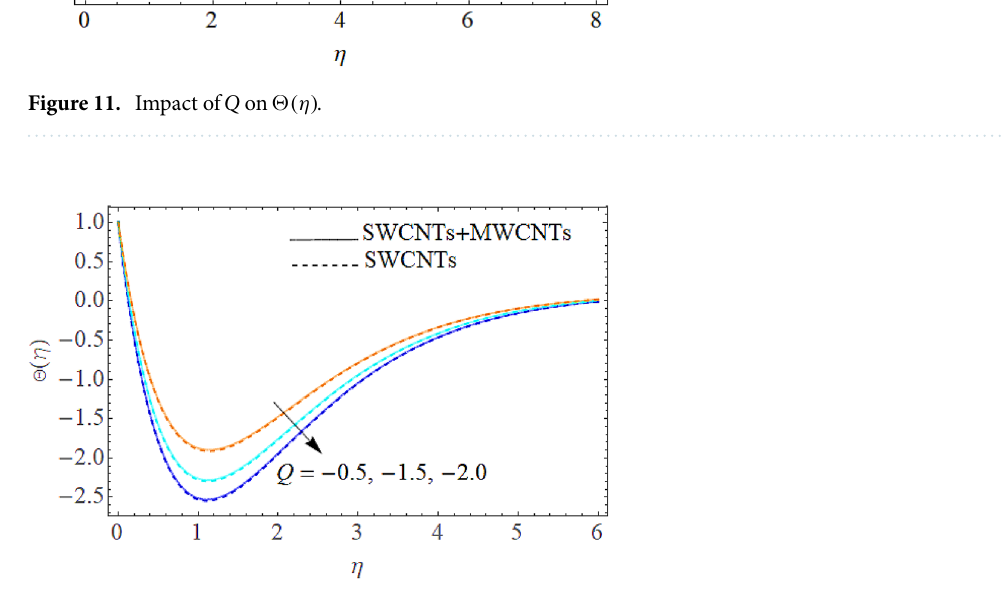
Figure 12. Impact of Q on �(η)